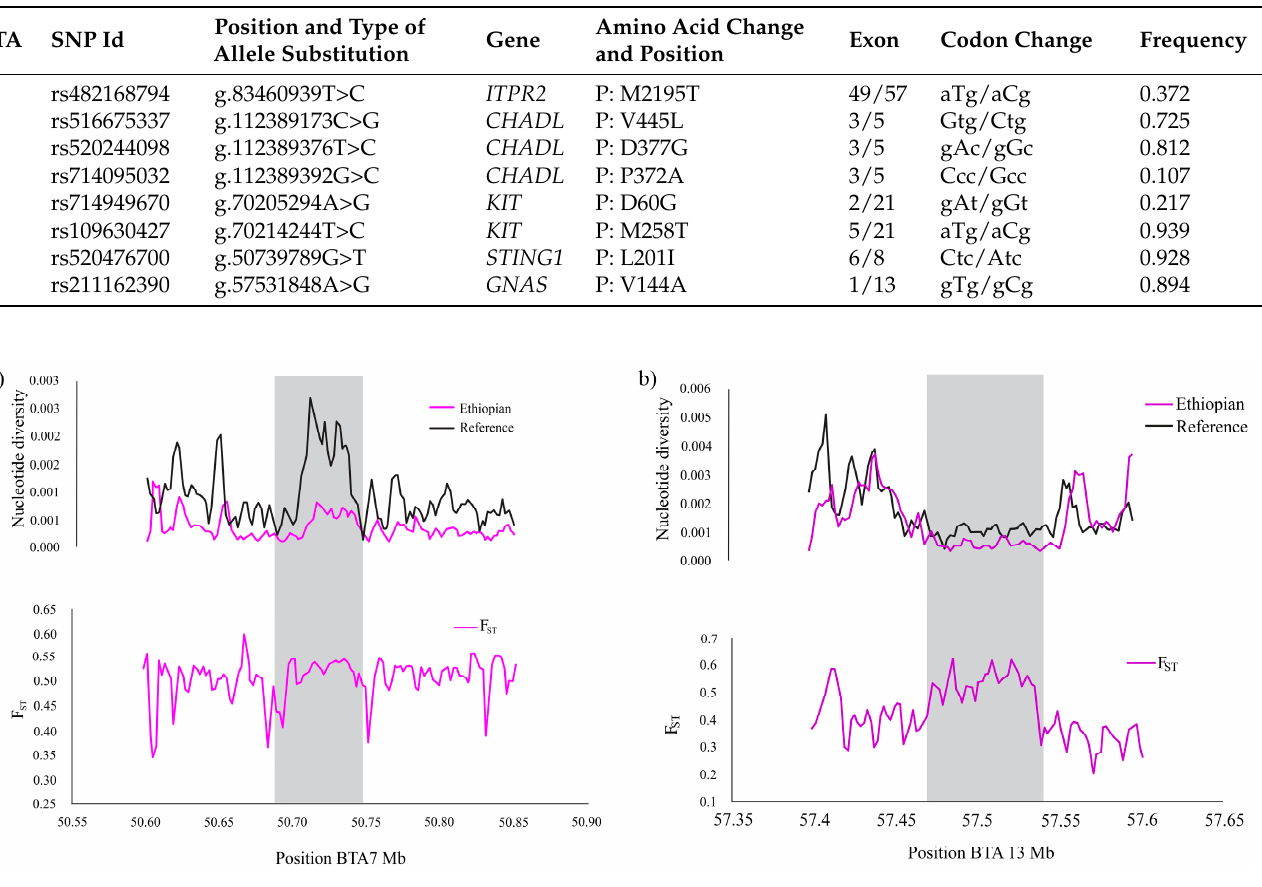
Figure 8. Plots of nucleotide diversity and population differentiation. ( a ) GNAS and ( b ) MZB1 gene regions based on the comparison between Ethiopian (purple color line) and non-Ethiopian cattle (black color line).